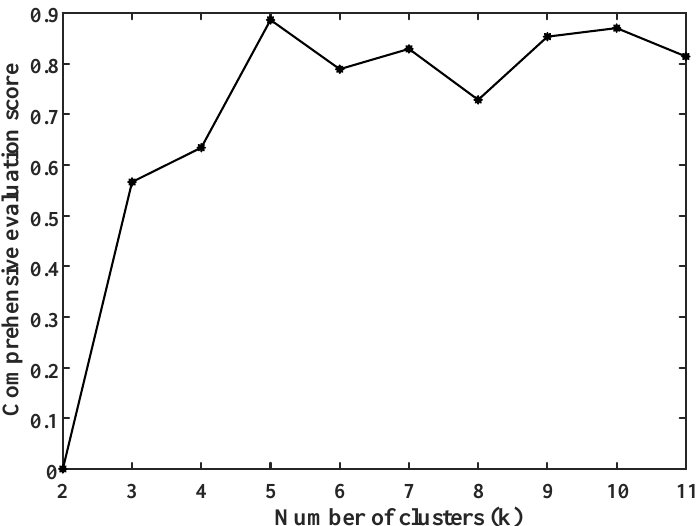
Figure 9. Comprehensive evaluation scores under different clustering number k .